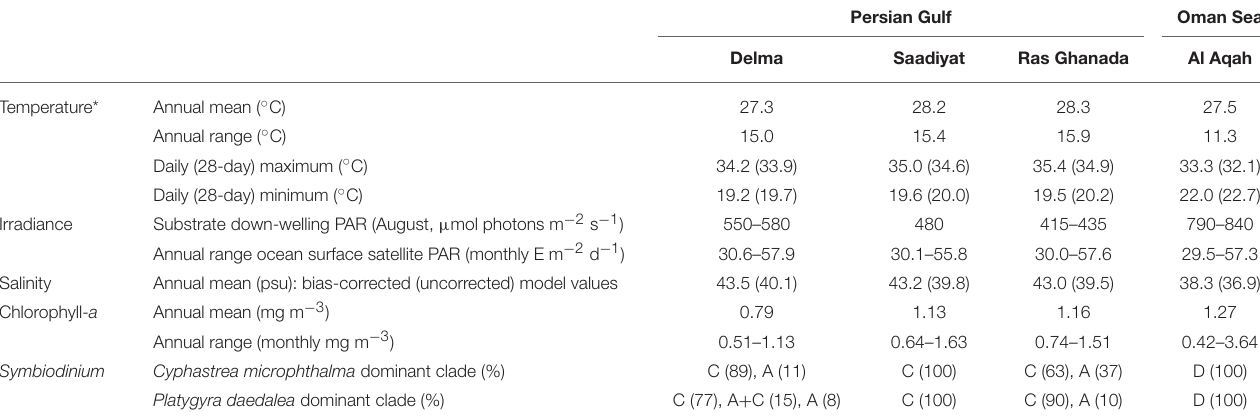
TABLE 1 | Environmental parameters at each site where coral growth was measured in the Persian Gulf and Oman